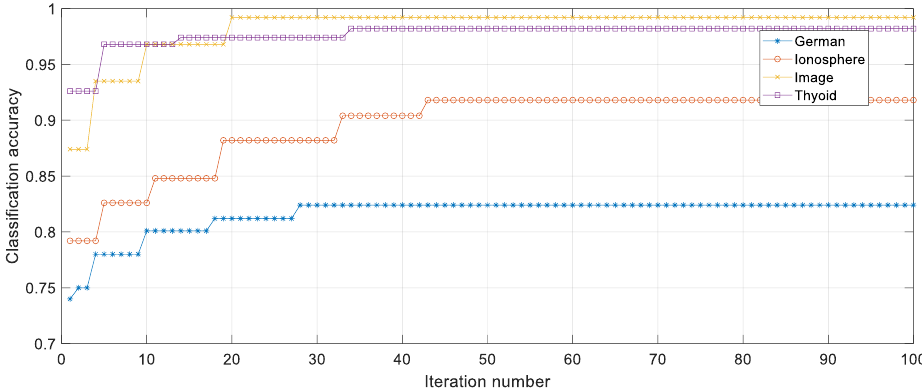
Figure 5. SQGA optimization results of different datasets.